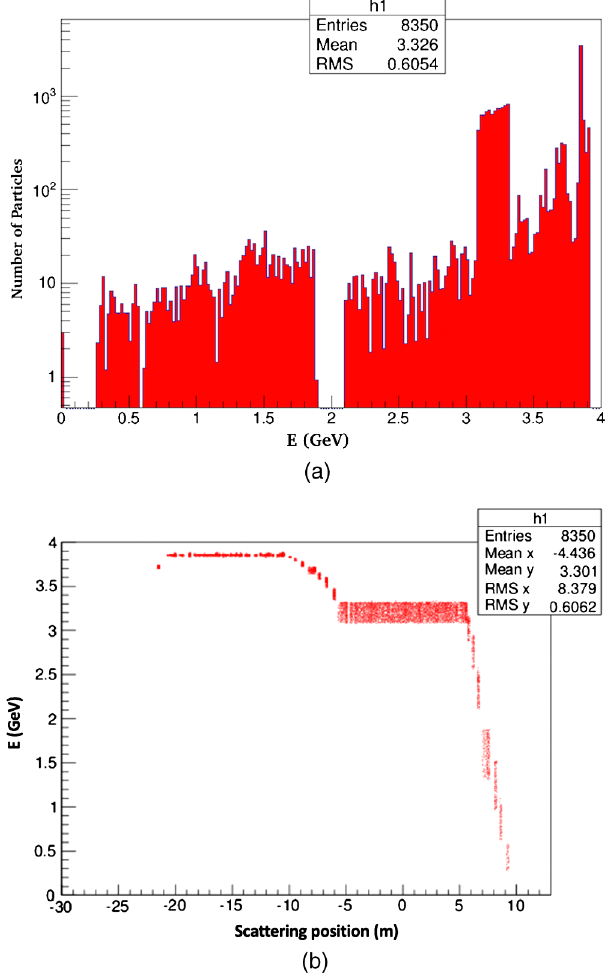
FIG. 4. (a) Simulated energy spectrum of the subset of bremsstrahlung positrons which are lost in the drift where we place our DS and (b) their energy as a function of their scattering position (0 represents the